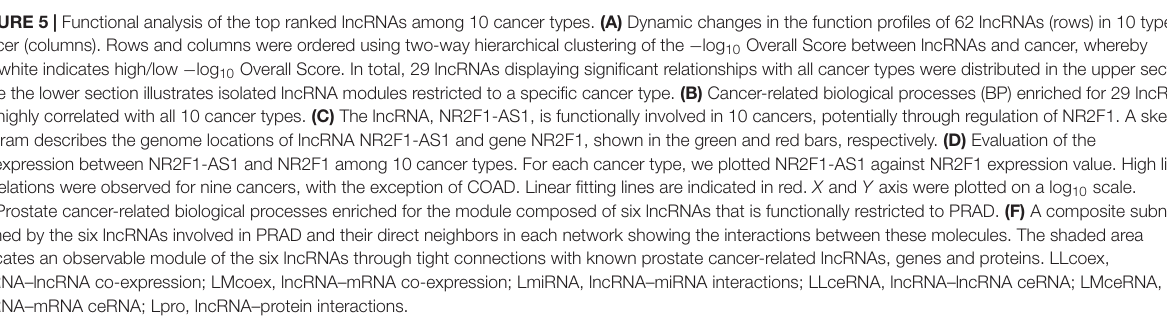
FIGURE 5 | Functional analysis of the top ranked lncRNAs among 10 cancer types. (A) Dynamic changes in the function profiles of 62 lncRNAs (rows) in 10 types of cancer (columns). Rows and columns were ordered using two-way hierarchical clustering of the − log 10 Overall Score between lncRNAs and cancer, whereby red/white indicates high/low − log 10 Overall Score. In total, 29 lncRNAs displaying significant relationships with all cancer types were distributed in the upper section while the lower section illustrates isolated lncRNA modules restricted to a specific cancer type. (B) Cancer-related biological processes (BP) enriched for 29 lncRNAs are highly correlated with all 10 cancer types. (C) The lncRNA, NR2F1-AS1, is functionally involved in 10 cancers, potentially through regulation of NR2F1. A sketch diagram describes the genome locations of lncRNA NR2F1-AS1 and gene NR2F1, shown in the green and red bars, respectively. (D) Evaluation of the co-expression between NR2F1-AS1 and NR2F1 among 10 cancer types. For each cancer type, we plotted NR2F1-AS1 against NR2F1 expression value. High linear correlations were observed for nine cancers, with the exception of COAD. Linear fitting lines are indicated in red. X and Y axis were plotted on a log 10 scale. (E) Prostate cancer-related biological processes enriched for the module composed of six lncRNAs that is functionally restricted to PRAD. (F) A composite subnet formed by the six lncRNAs involved in PRAD and their direct neighbors in each network showing the interactions between these molecules. The shaded area indicates an observable module of the six lncRNAs through tight connections with known prostate cancer-related lncRNAs, genes and proteins. LLcoex, lncRNA–lncRNA co-expression; LMcoex, lncRNA–mRNA co-expression; LmiRNA, lncRNA–miRNA interactions; LLceRNA, lncRNA–lncRNA ceRNA; LMceRNA, lncRNA–mRNA ceRNA; Lpro, lncRNA–protein interactions.